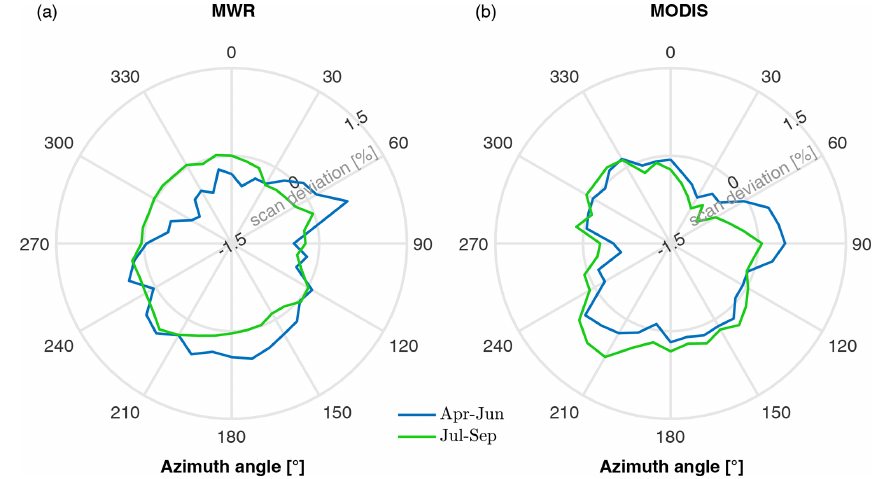
Figure 3. (a) Mean values of the MWR water vapor deviation (integrated up to the CBL height) from the mean per scan between 12:00 and 17:00UTC for April–June (99 scans) and July–September (123 scans). (b) Same as panel (a) but for the MODIS IWV deviations including 22 overpasses (April–June) and 36 overpasses (July–September),